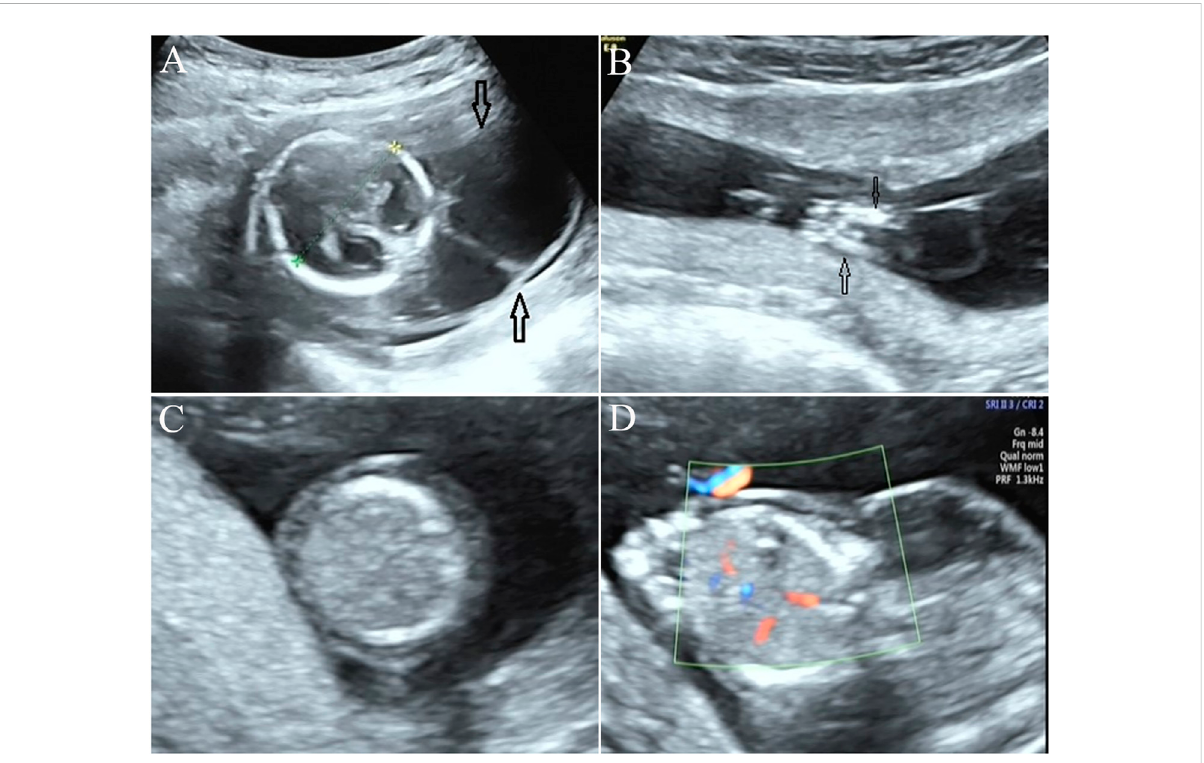
FIGURE 1 Prenatalultrasonicexaminationresultsofthefetus. (A) Ultrasoundexaminationelicitedneckwatersactumorinthefetus. (B) Approach, fl exion, and fi xation of both lower limbs were observed in the fetus, indicating joint contractures. (C,D) : the trunk skin layer is obviously thickened, and the echo is reduced, and diagnosed as fetal